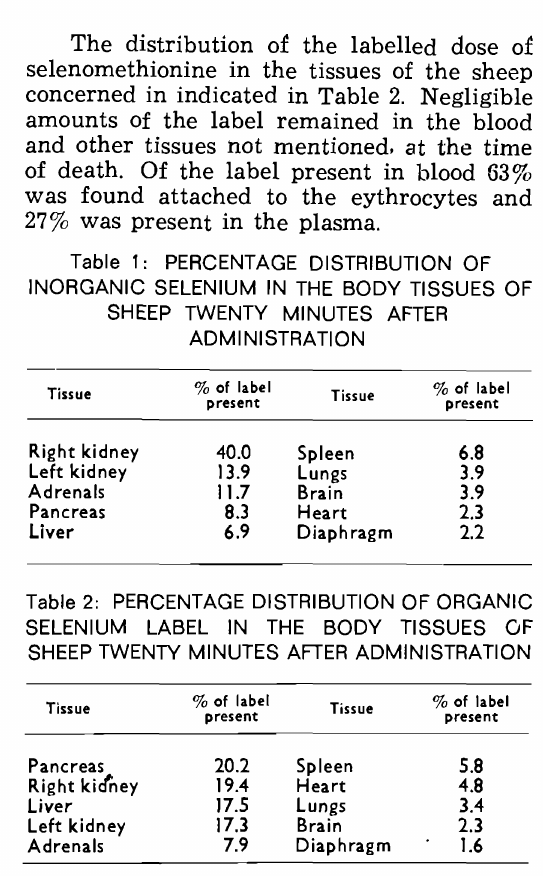
Table 2: PERCENTAGE DISTRIBUTION OF ORGANIC SELENIUM LABEL IN THE BODY TISSUES OF SHEEP TWENTY MINUTES AFTER